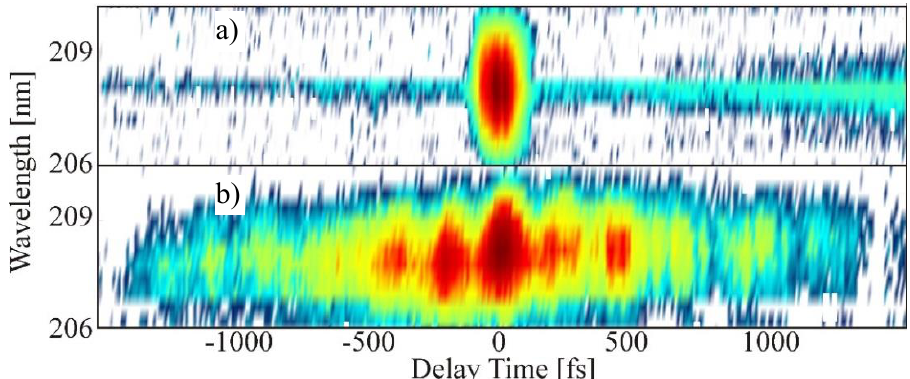
Fig. 2: First time deep UV phase shaping and transient grating frequency resloved optical gating (TG-FROG). Transform limited UV pulses in (a) are trasnfered into a pulse train (b) through sinusoidal phase shaping at the fundamental priorr to the TiSa amplifier and subsequent frequency quadripling in accordig to a Fourier nonliner optics